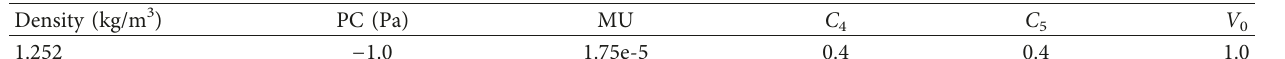
Table 6: Air status parameter.